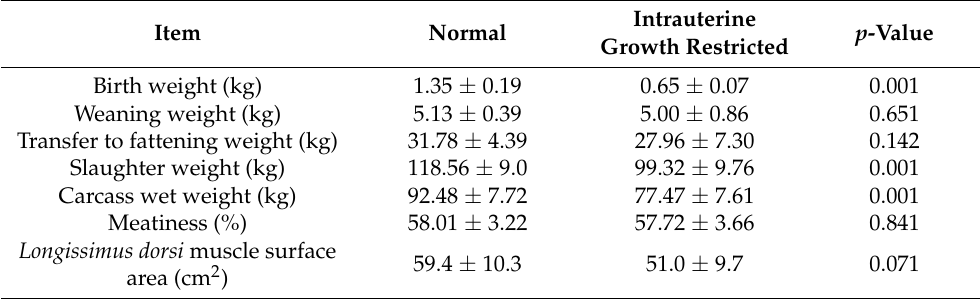
Table 2. Body and carcass weights, meatiness, and longissimus dorsi muscle surface area of the nor- mal ( n = 12) and intrauterine growth restricted ( n = 11) pig pairs from birth to slaughter. Mean ± SD, Student t -test.